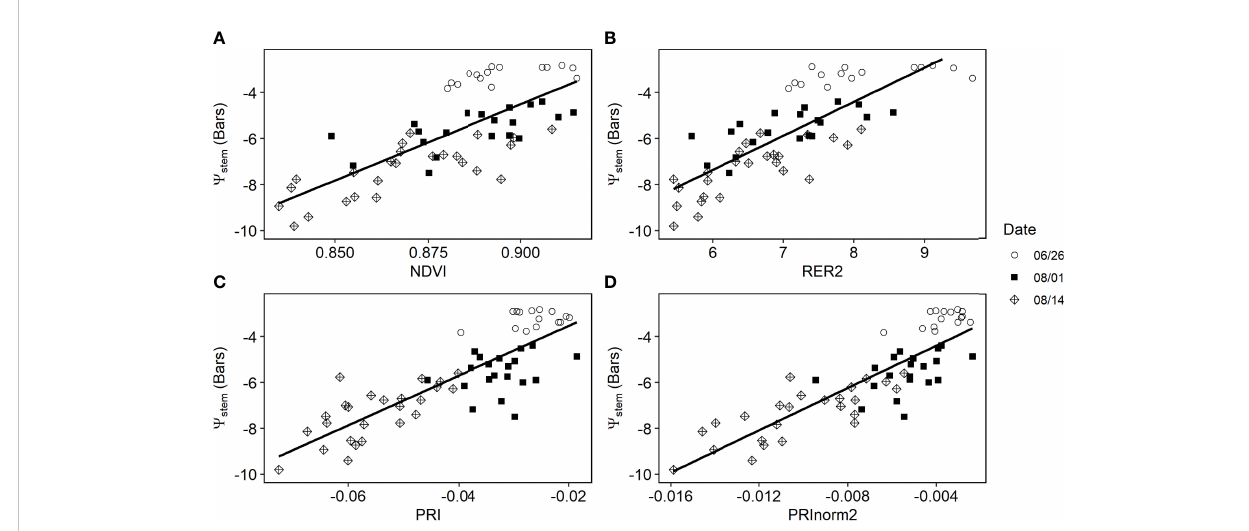
FIGURE 10 Scatterplots of vegetation indices from the multispectral unmanned aerial vehicle imagery, including (A) normalized difference vegetation index, (B) Red Edge Ratio 2, (C) photochemical re fl ectance index, and (D) normalized photochemical re fl ectance index vs . measured stem water potential ( y stem ) over the sampled plots.